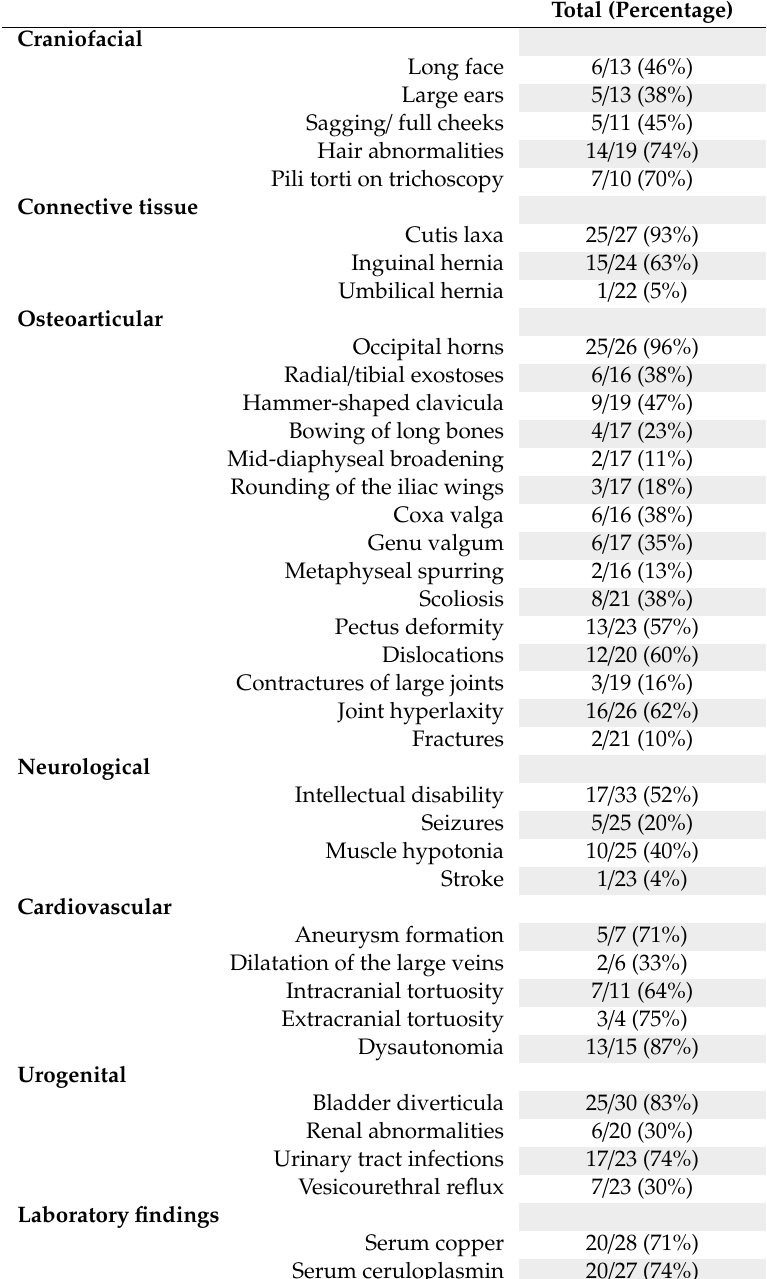
Table 1. Overview of the phenotypic presentation in occipital horn